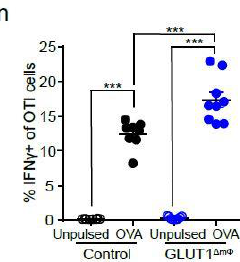
Figure 4. NK cells and CTLs mediate anti-tumor immunity in GLUT1 ∆ m Φ mice. ( a – g , i – l ) Flow cytometry was performed in. control and GLUT1 ∆ m Φ mice to assess NK and CTL populations. Flow cytometry gating strategy shown in Supplementary Figure S4b. Shown are scatter plots of the % CD4+ T cells ( a ), % CD8+ T cells ( b ), and % NK cells ( c ) of the total CD45+ population in the pancreata of control (black) and GLUT1 ∆ m Φ (blue) mice ( n =14 mice per group, pooled from four independent experiments). Shown are scatter plots of % IFN γ + ( d ), % Perforin+ ( e ), % Granzyme B+ ( f ) ( n = 16 mice per group, pooled from three independent experiments, representative flow plots are shown in Supplementary Figure S4c) and % CD69+ ( g ) ( n = 6 mice per group) of total NK cells in the pancreata of control (black) and GLUT1 ∆ m Φ (blue) mice. ( h ) NK cells were depleted in vivo by injecting 250 µ g of either isotype (open bars) or anti-NK1.1 (filled bars) antibody i.p. per mouse, once a week. Shown are bar graphs of the tumor weight measured at Day 28 of control and GLUT1 ∆ m Φ mice ( n = 5 mice per group, representative of two independent experiments). ( i – l ) Shown are scatter plots of % IFN γ + ( i ), % Perforin+ ( j ), % Granzyme B+ ( k ) ( n = 16 mice per group, pooled from three independent experiments) and % CD69+ ( l ) ( n = 6 mice per group_of total CD8+ T cells in the pancreata of control (black) and GLUT1 ∆ m Φ (blue) mice. ( m ) CD8+ T cells are depleted in vivo by injecting 500 µ g of either isotype (open bars) or anti-CD8 α (filled bars) antibody i.p. per mouse, once a week. Shown are bar graphs of the tumor weight measured at Day 27 of control and GLUT1 ∆ m Φ mice (at least n = 5 mice per group). Data are means ± SEM, * p < 0.05; ** p < 0.01; *** p < 0.001 by unpaired student’s t-test with 95% confidence interval. ( n ) Scatter plot of % IFN γ + CD8+ OTI cells after co-culture with either unpulsed or OVA-pulsed macrophages isolated from the pancreata of control (black) and GLUT1 ∆ m Φ (blue) mice ( n ≥ 8 mice per group). Data are means ± SEM, *** p < 0.001 by one-way ANOVA with Bonferroni post-hoc